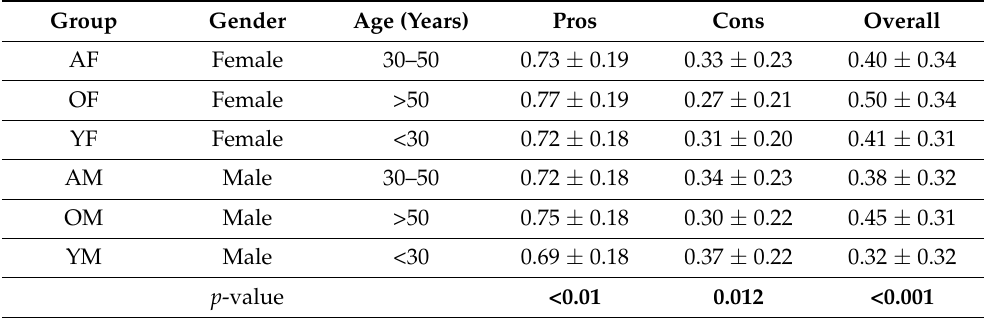
Table 10. Mean and standard deviation of preparedness scores by gender and age and p -values from the Kruskal-Wallis test ( α = 0.05). Pros [0, 1] = in favour of preparedness; Cons [0, 1] = against